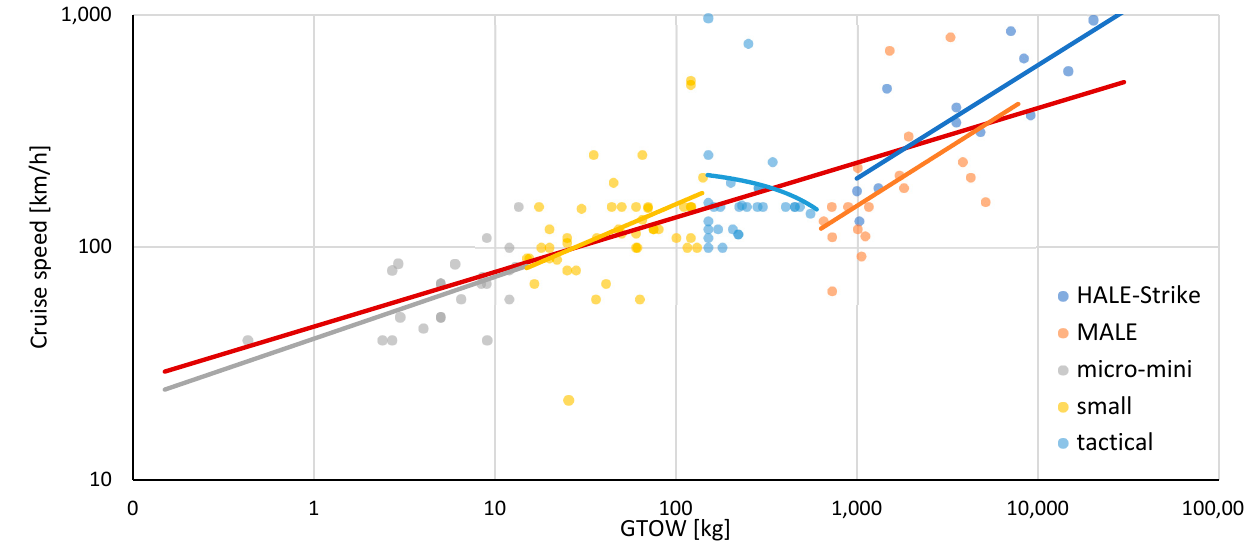
Figure 21. Cruise speed as a function of GTOW with respect to NATO classification. The color code is identical to the one described in Figure 6. Table 9. Statistical data regarding the trend fitting for the cruise speed vs. GTOW plots. R 2